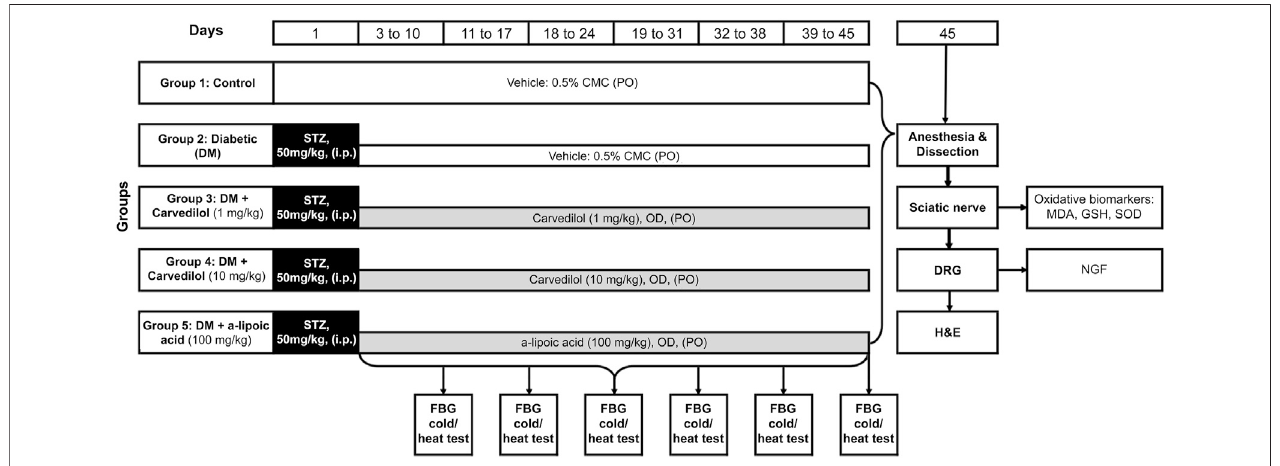
FIGURE 1 | Structural summary of the study